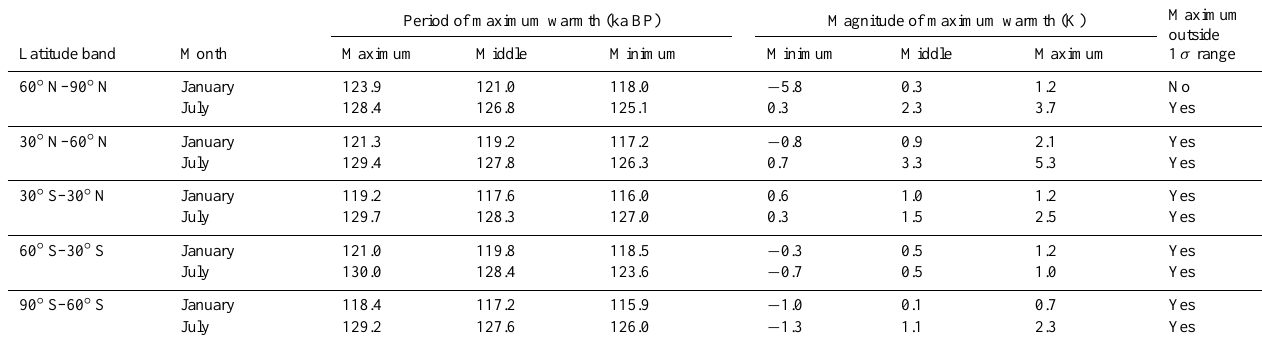
Table 2. List of the MMM timing of the period of maximum LIG warmth (ka BP) and the corresponding temperature anomalies (K) for every latitude band and for both January and July. The time interval of maximum warmth and the corresponding temperature anomalies are calculated as follows: the middle of the period is the time for which the maximum MMM temperature is found, which is in turn the middle temperature given in column seven; the maximum and minimum of the period of maximum warmth are the mid-point ± 1 σ , which gives a measure of the spread in the periods of maximum warmth of the individual simulations (for details see captions of Figs. 2 and 3); the temperature range is found by taking the minimum and maximum of the MMM temperatures ± 1 σ occurring during the period of maximum warmth. In the last column it is given if the mid-point of the MMM period of maximum warmth is outside the 1 σ range of the LIG MMM average temperature. Note that, in all simulations underlying these results, a fixed-day calendar was used. MaximumPeriod of maximum warmth (ka BP) Magnitude of maximum warmth (K) outside Latitude band Minimum